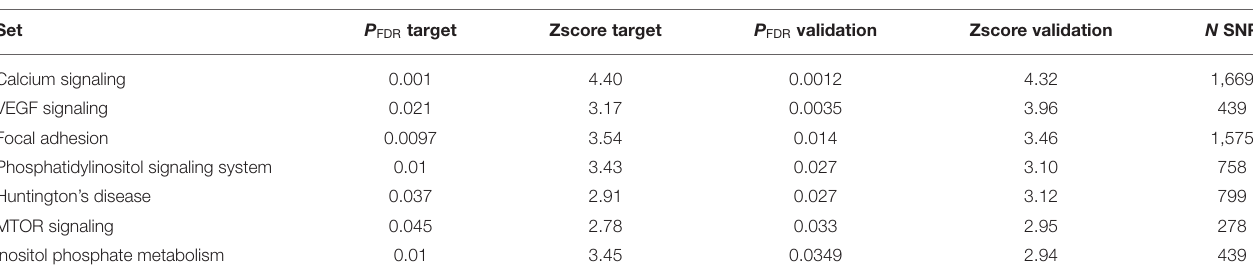
TABLE 3 | Significant pathway-specific PRS in both target and validation